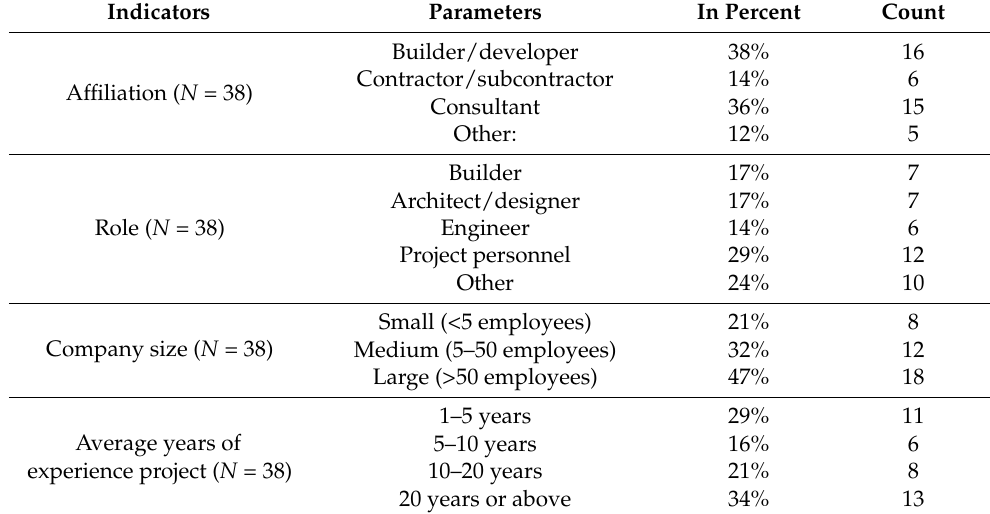
Table 2. Respondents’ demographic